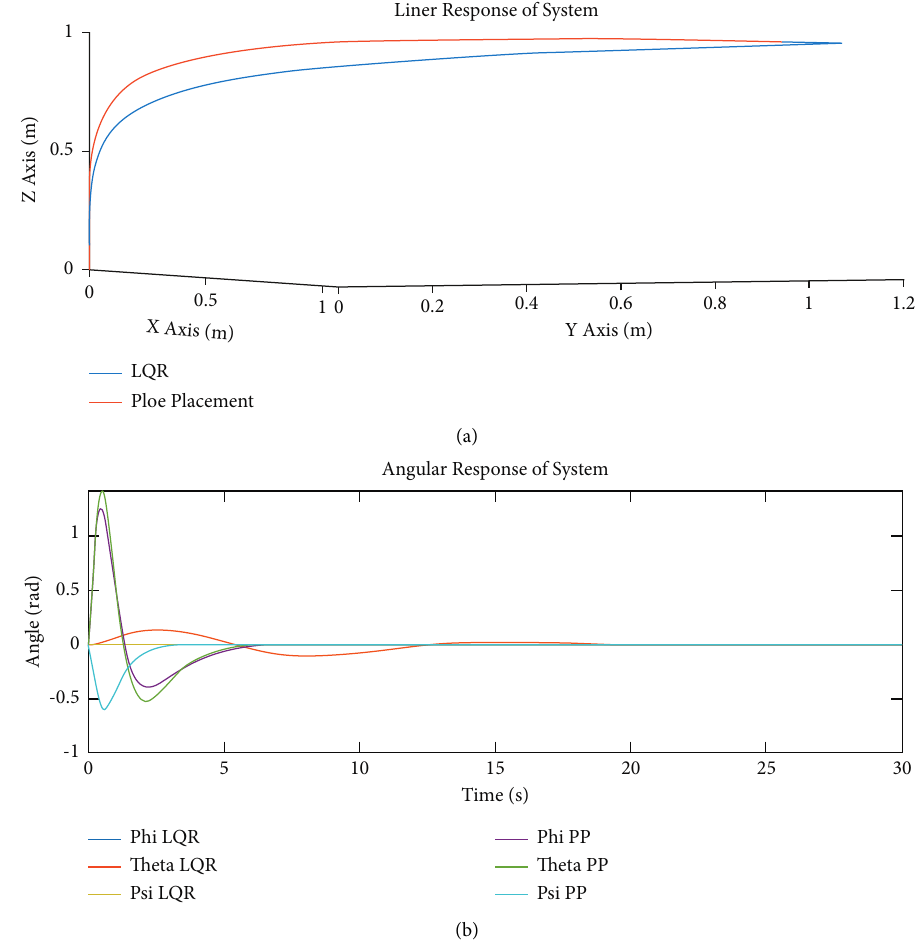
Figure 5: Pole Placement and LQR Controllers response comparison for system. (a) Liner Response of system. (b) Angular Response of system.